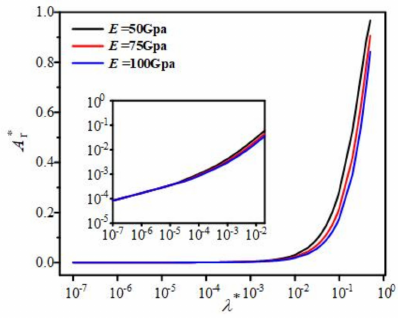
Figure 9. Dimensionless real contact area versus observation scale λ * with various E .